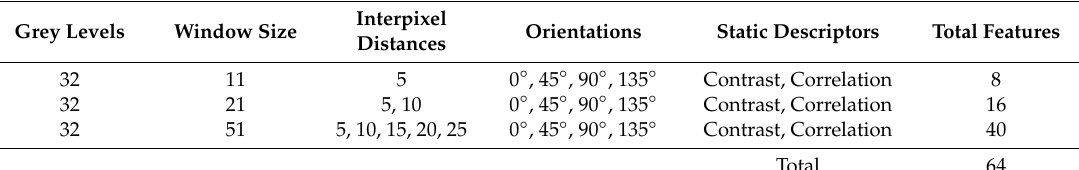
Table 5. Summary of parameters used in GLCM